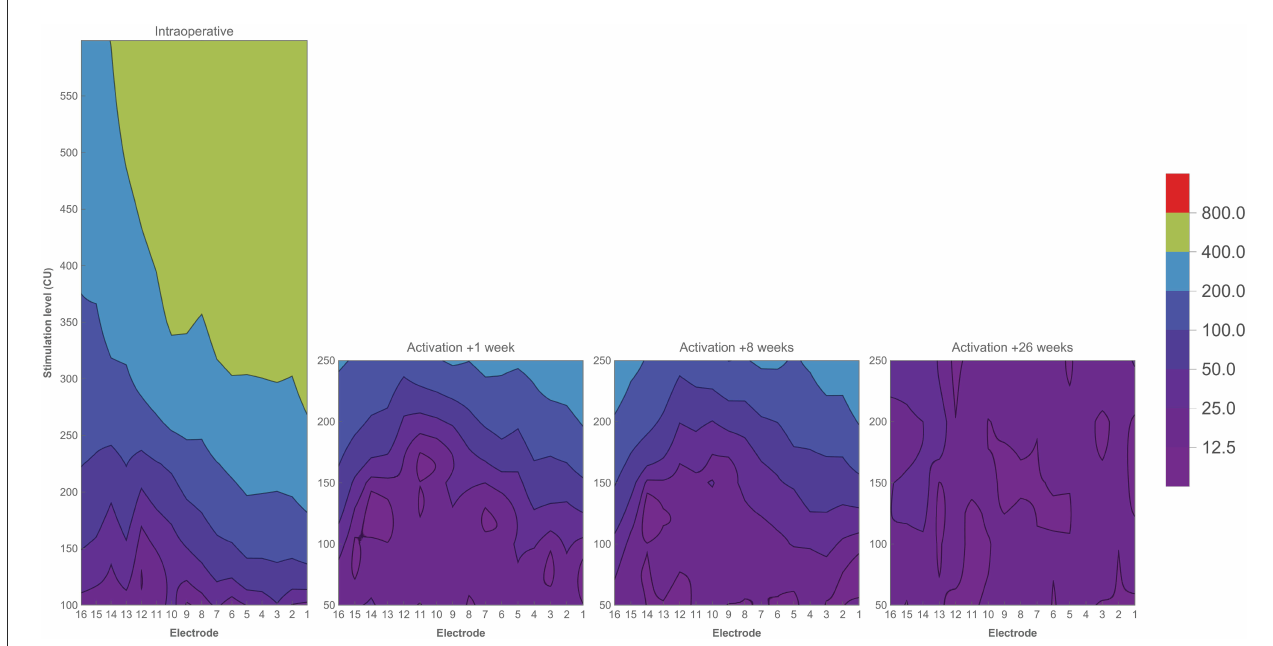
FIGURE5 Contour plots of one subject (EP08) showing ECAP responses ( µ V) in relation to stimulation level (CU) across the electrode array. Colors indicate ECAP values ( µ V) according to the legend. Measurements have been performed during CI surgery, and at three return visits during the first 6 months of CI